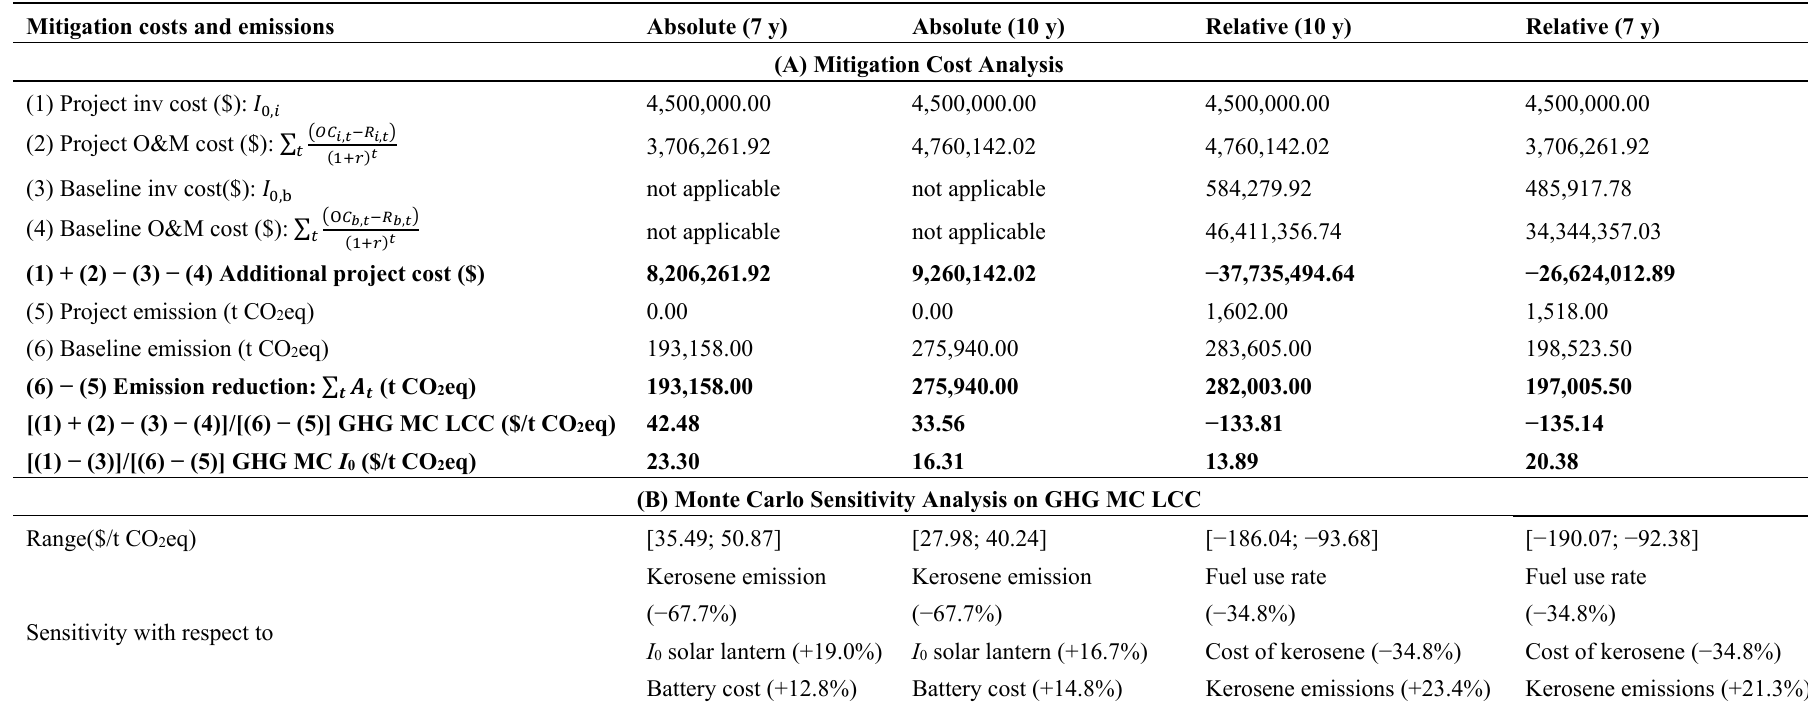
Table 1. Greenhouse Gas (GHG) mitigation costs of solar light emitting diode (LED) lanterns vs. kerosene